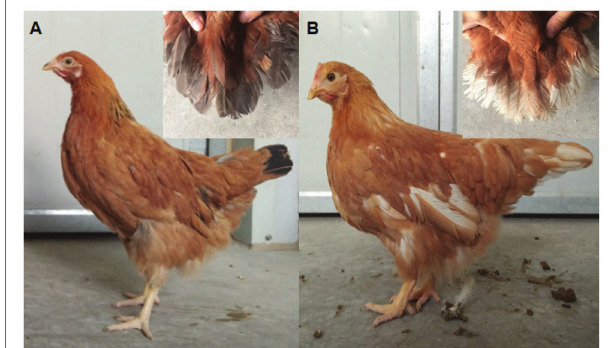
FIGURE 2 | Dwarf hens displaying white or black tail feather color. (A) Black tail; (B) white tail.